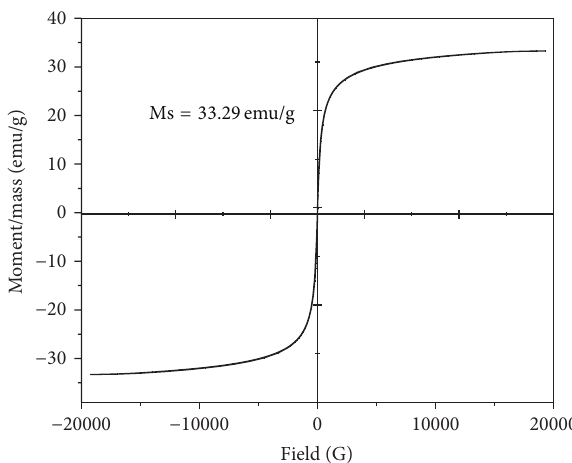
Figure 3: Magnetic hysteresis loop of TiO 2 -Fe 3 O 4 -bentonite at 298 K.